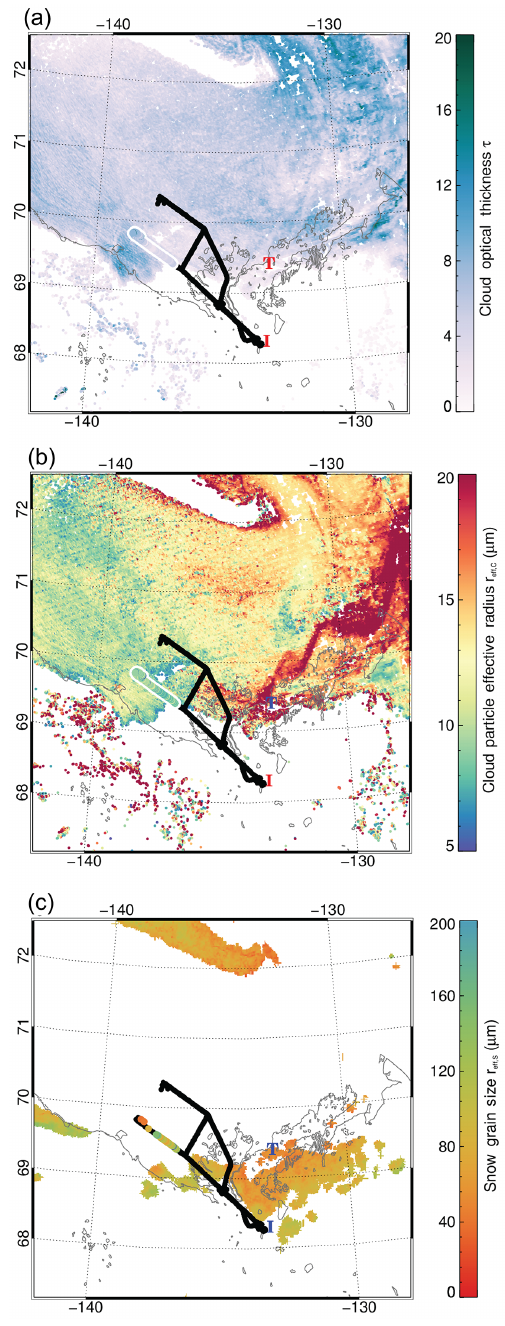
Figure 10. Same as Fig. 8 but for 17 May